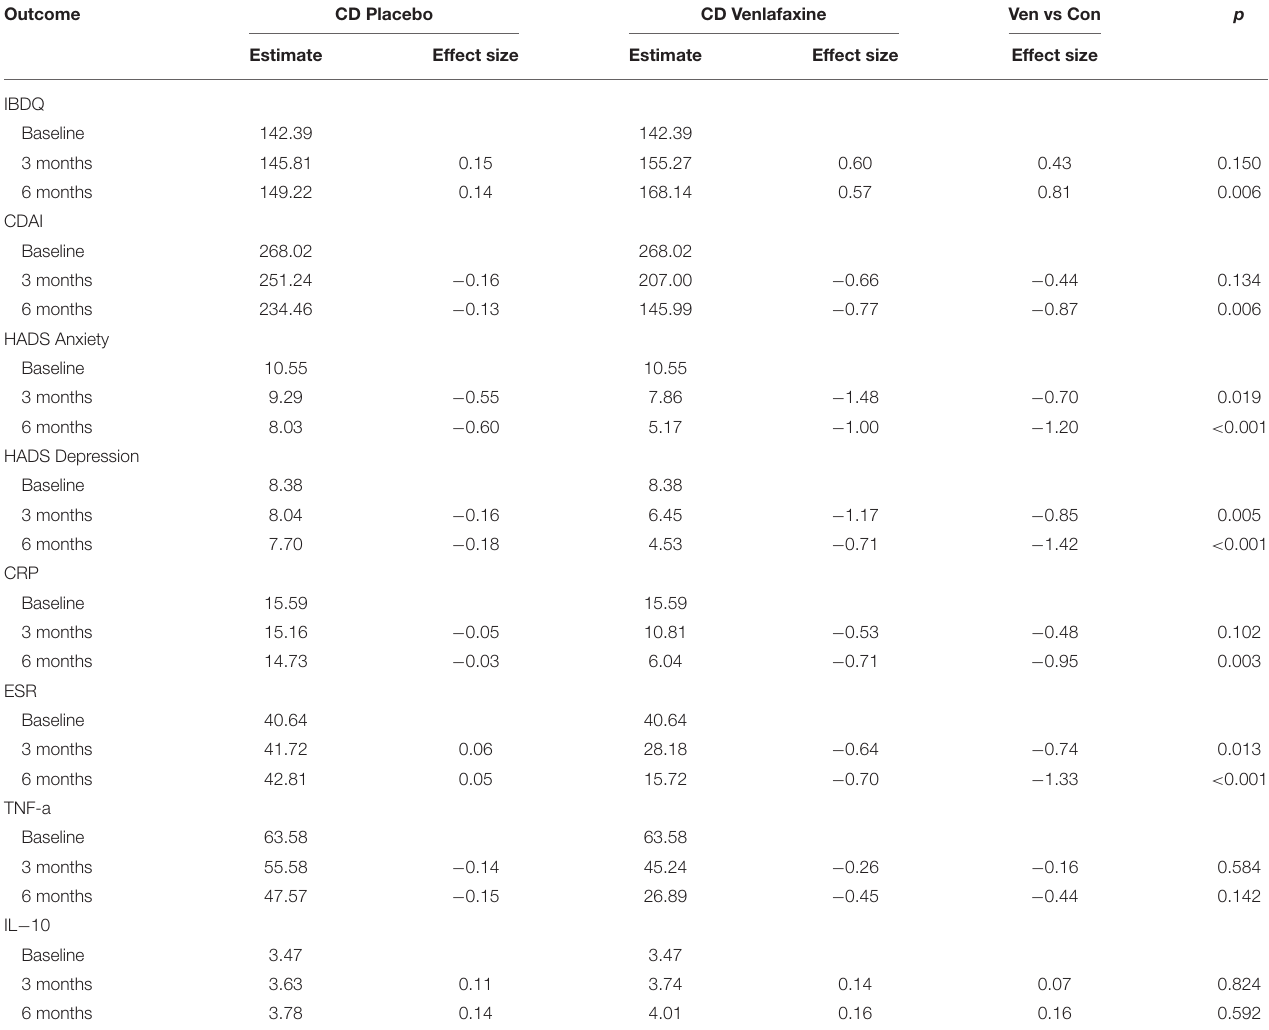
TABLE 4 | Estimates and effects sizes for venlafaxine group and placebo group in CD. Outcome CD Placebo CD Venlafaxine Ven vs Con p Estimate Effect size Estimate Effect size Effect